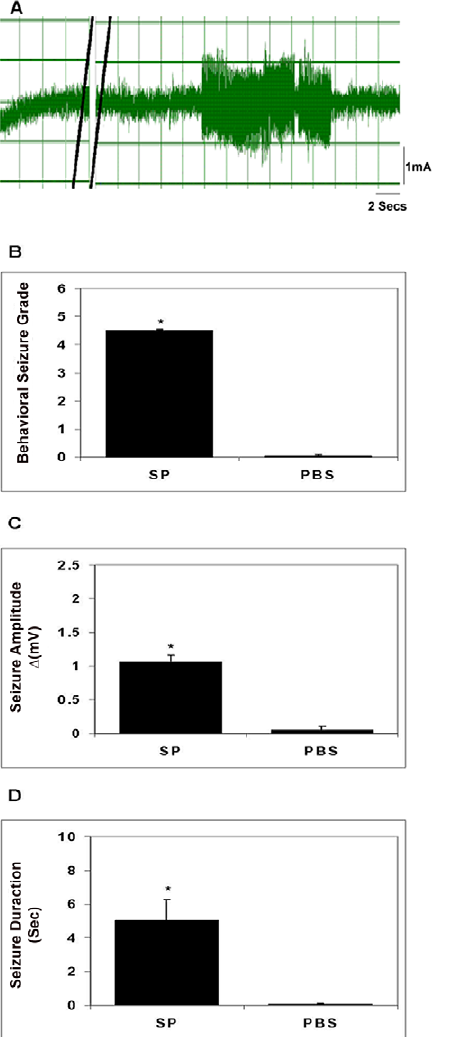
Figure 2. Seizure activity in rats following intrahippocampal injection of SP. A representative EEG recording before and after injection of SP into the hippocampus of a rat is shown in panel A; double black lines indicate period of SP injection. The behavioral seizure grade (B), seizure amplitude (C), and seizure duration (D) following intrahippocampal injection of SP or vehicle (PBS) in rats (n=4–6) are depicted graphically (results shown are mean 6 SEM; *, p # 0.001, Mann-Whitney). Results are pooled data from two independent experiments.